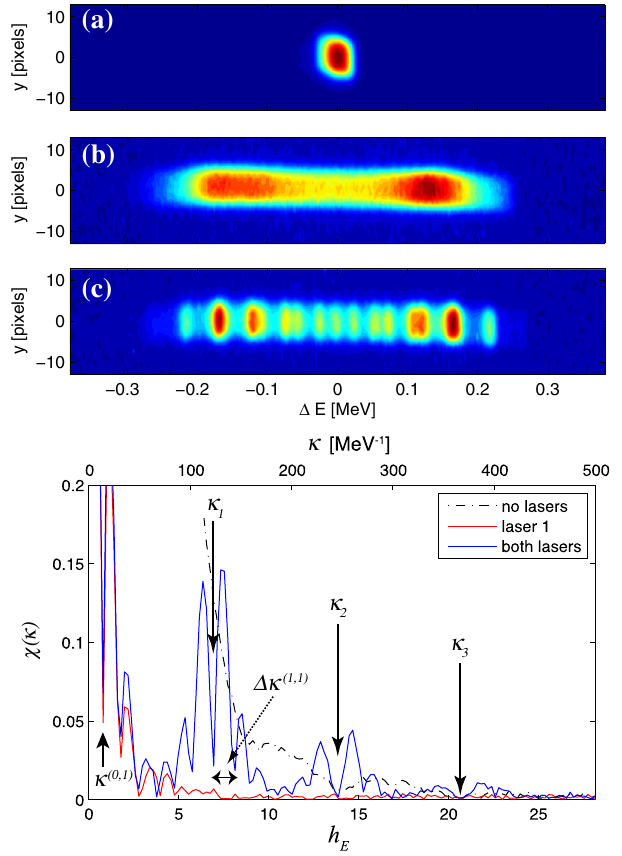
FIG. 2 (color online). Top: Measured e-beam energy distribu- tions at bend spectrometer with (a) no laser modulation, (b) first laser on, and (c) both lasers on. Bottom: Energy spectra for each case, with the harmonic frequencies κ n ¼ nk 1 R 56 =E 0 identified from theory.